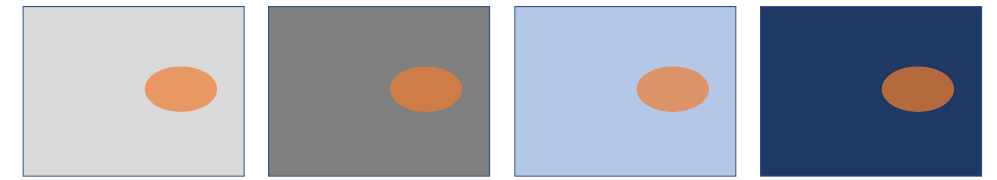
Figure 8. Effect of surrounding luminance values and colors on the brightness of target color. A blue and gray background pair, with the orange RGB value on the left (231,153,99) and on the right (207,125,70), respectively.